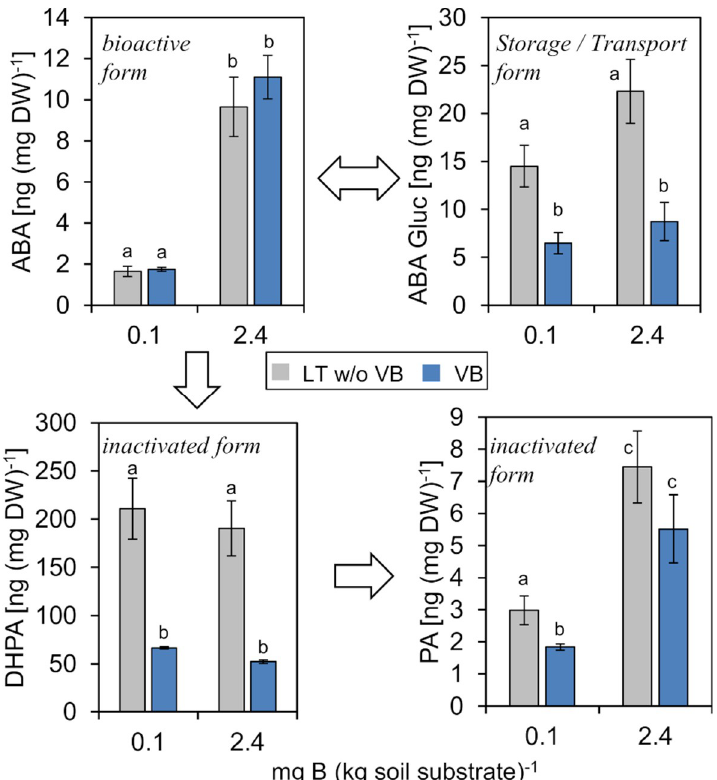
Figure 8. Concentration of abscisic acid (ABA), ABA-glucose ester (ABA Gluc), dihydrophaseic acid (DHPA), and phasic acid (PA) in vascular bundles (VB) or leaf tissue without VB (LT w/o VB) of P. major plants grown on low B (0.1 mg B (kg soil substrate) −1 ) or B-sufficient (2.4 mg B (kg soil substrate) −1 ) soil substrate. Arrows indicate metabolic conversions. Error bar labels with different letters indicate significant differences at p < 0.05 between treatments and tissues according to One-way ANOVA with post-hoc Tukey test.